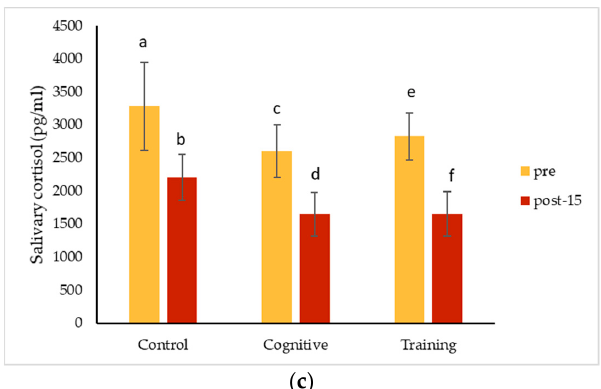
Figure 5. Salivary cortisol (mean ± standard error) before and after two types of human–animal interactions and a control condition for ( a ) Chip; ( b ) Pende; and ( c ) Kongo. Friedman tests comparing the change in hormone levels (calculated by subtracting the pre from the post-15 values) across conditions were non-significant for each gorilla. Bars with different letters within a condition are significantly different or trending at p < 0.10 comparing time points within that condition based on Wilcoxon signed rank tests with Monte Carlo sampling.